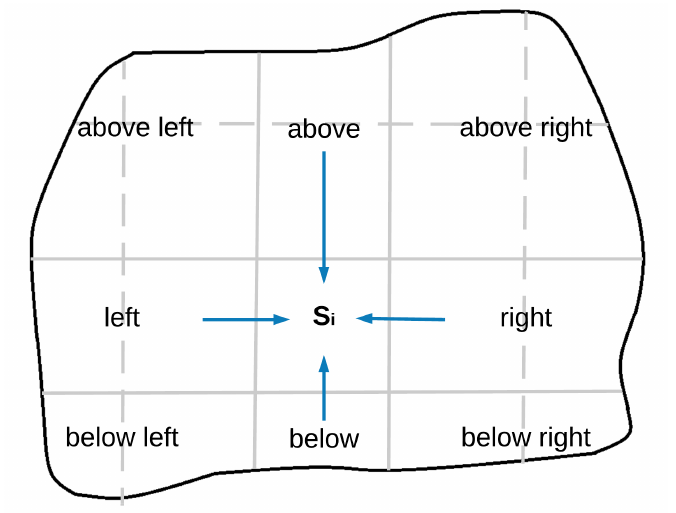
Figure 4. Area division and grouping depending on the side with respect to the sub-area assigned to the UAV Q i , considering a 4 × 5 grid